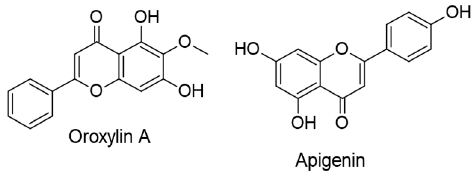
Figure 11. Chemical structures of flavones with therapeutic effects against KSHV-associated malignancies.